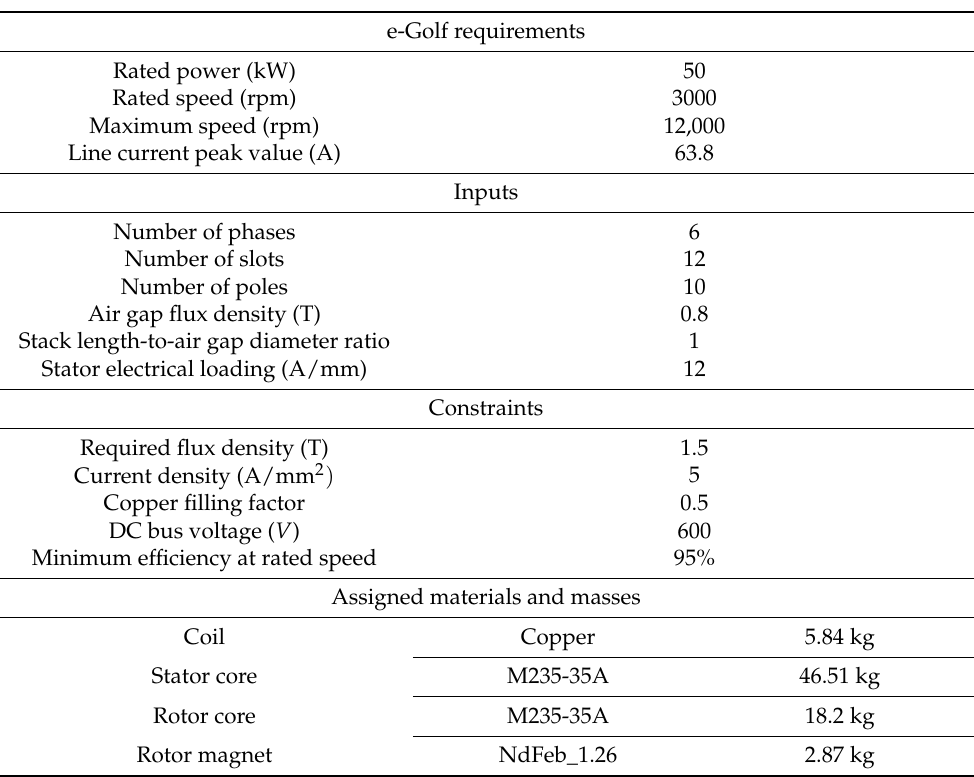
Table 1. SPM machine design